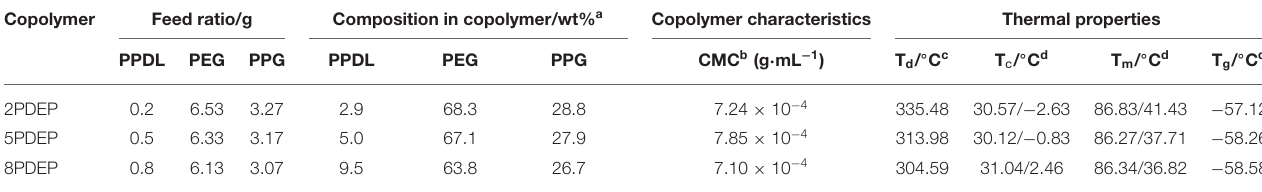
TABLE 1 | Molecular characteristics and properties of PDEP copolymers. Copolymer Feed ratio/g Composition in copolymer/wt% a Copolymer characteristics Thermal properties PPDL PEG PPG PPDL PEG PPG